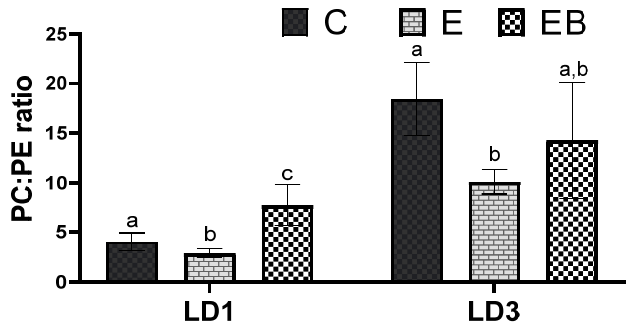
Figure 7. Analysis of PC:PE ratio in larger- (LD1) and smaller-sized LDs (LD3) of rats fed control (C), ethanol (E), or betaine-supplemented ethanol (EB) diet. Data are presented as the mean ± SEM ( n = 8); values not sharing a common letter significantly differ from each other at p ≤ 0.05.